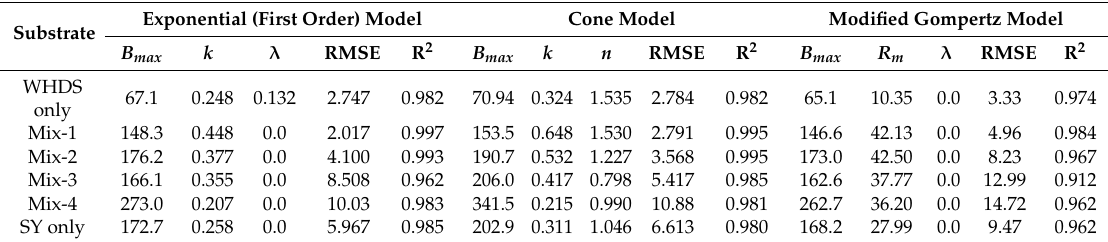
Table 4. Values of the parameters of the biomethane kinetic models (Equations (3)–(5)).